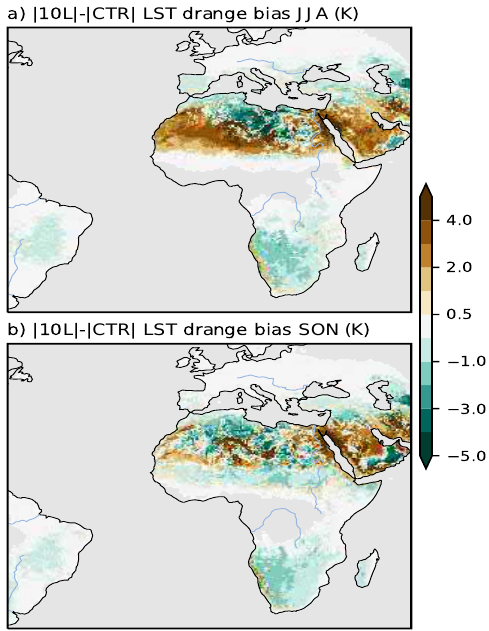
Figure 20. Difference in absolute mean diurnal range (drange) bias of Land Surface Temperature (LST) between the simulation with OSML10_TW (10L) and the control (CTR) simulation for JJA ( a ) and SON ( b ). The statistics were computed for the period 2004 to 2015 considering only clear-sky conditions. The biases of the control simulation are shown Figure 9.